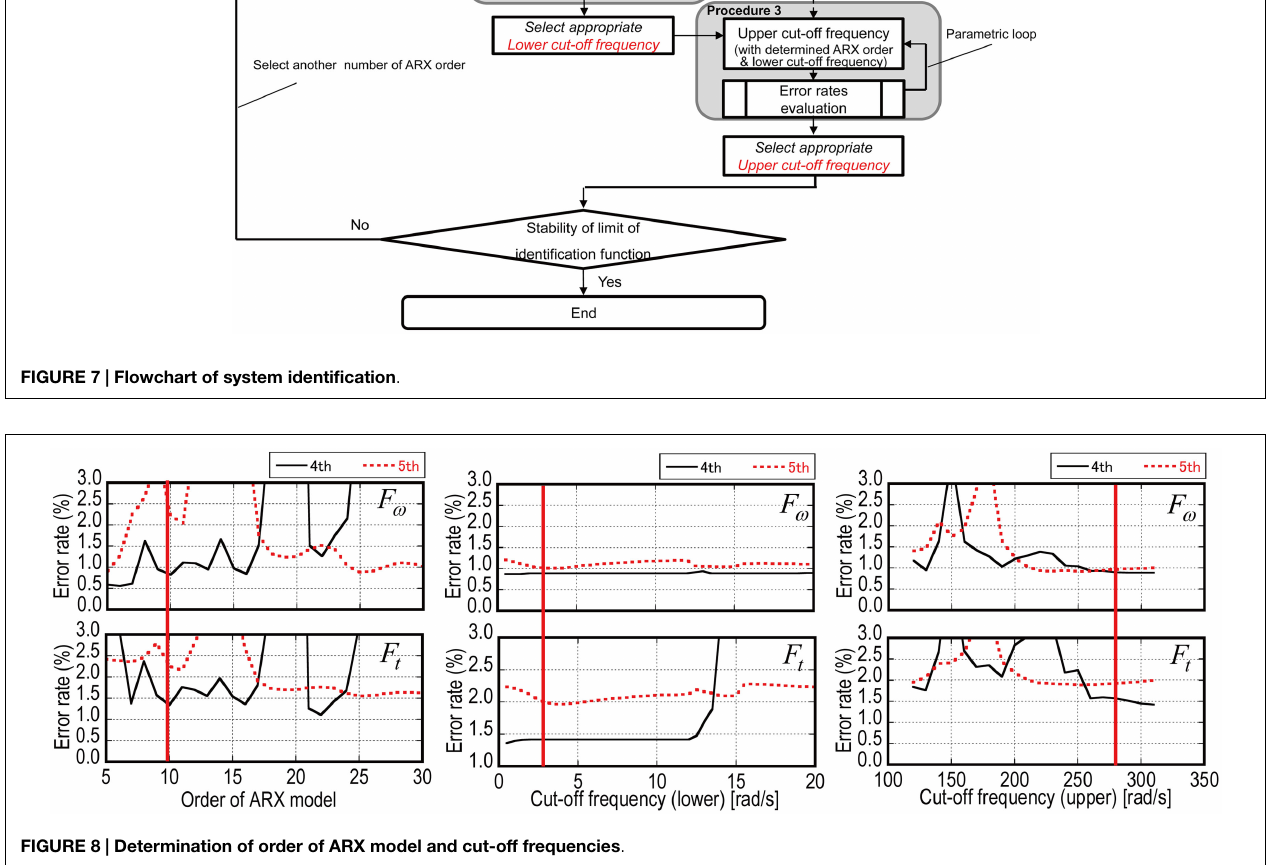
FIGURE 8 | Determination of order of ARX model and cut-off frequencies .